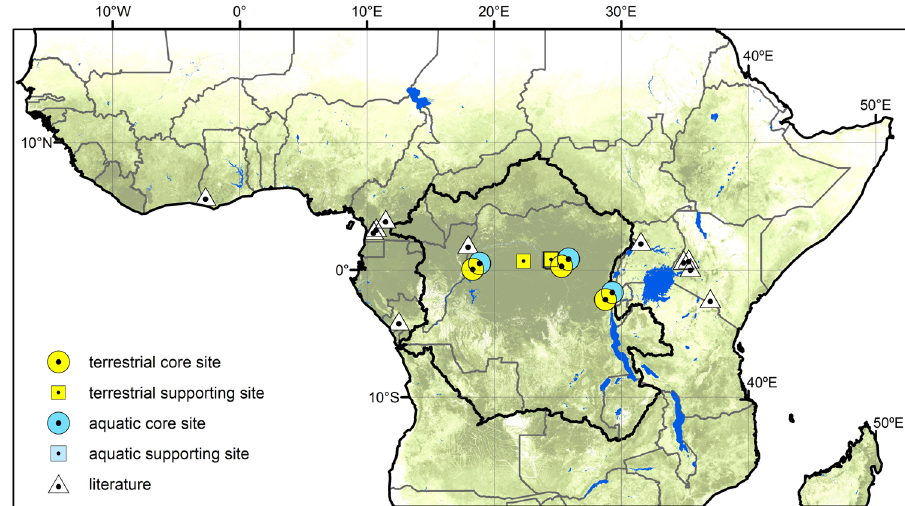
Fig. 1 Forest cover of sub-Saharan Africa. 2019 forest cover of sub-Saharan Africa (0% white, 100% dark green) 78 with Congo Basin boundary delineation in black showing all currently published in situ African tropical forest studies on N 2 O and/or CH 4 in white triangles 12 – 23 and this study in yellow (terrestrial) and blue (aquatic). Circles represent core long-term observation sites and squares represent supporting sites. Riverine dissolved CH 4 and N 2 O samples were taken from headwater streams draining the same catchments in which the core sites were